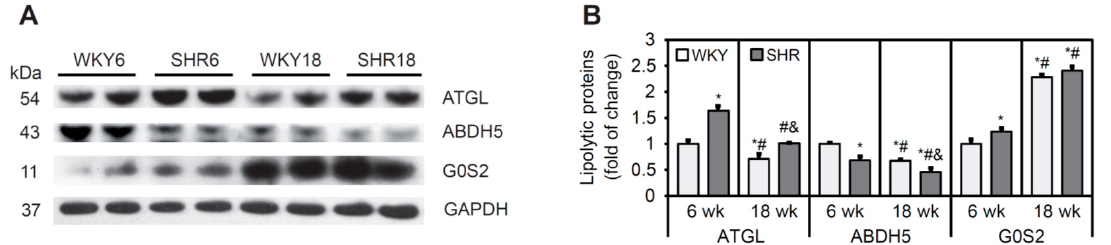
Figure 5. The process of lipolysis in cardiomyocytes in SHRs. ( A , B ) Protein levels of adipose triglyceride lipase (ATGL), α / β -hydrolase domain containing 5 (ABDH5), and G0/G1 switch protein 2 (G0S2) were determined by Western blot. The results are expressed as mean ± SD. n = 10; LV form 5 rats were merged in one sample and 3 different gels were run. * p < 0.05, vs. WKY6 group; # p < 0.05, vs. SHR6 group; & p < 0.05, vs. WKY18 group.